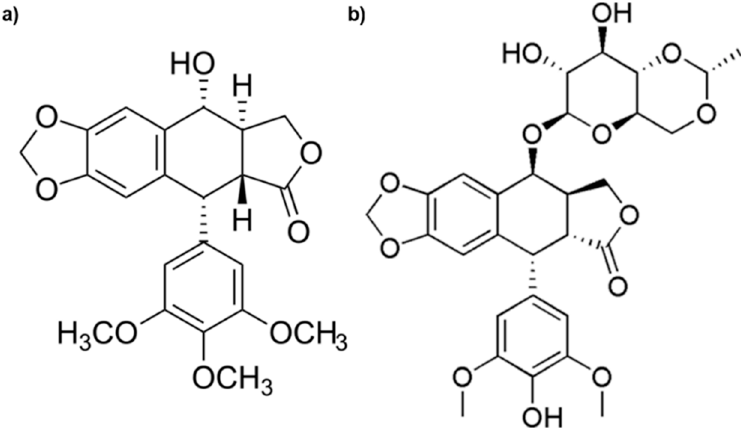
Figure 1. Chemical structures of Podophyllotoxin ( a ) and Etoposide ( b ).